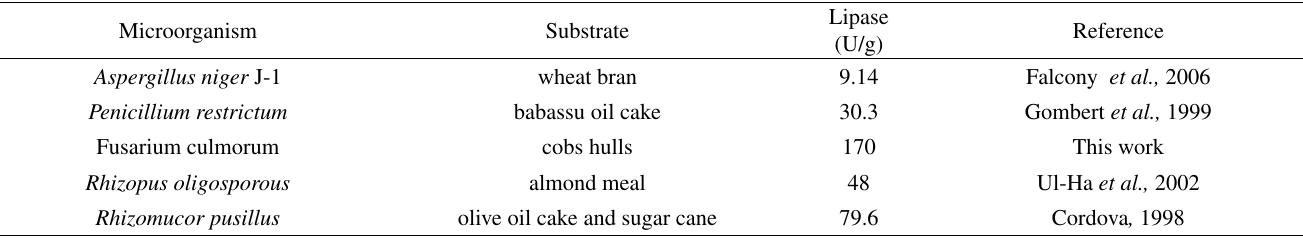
Table 1 - Optimum lipase activities produced by filamentous fungi grown in SS